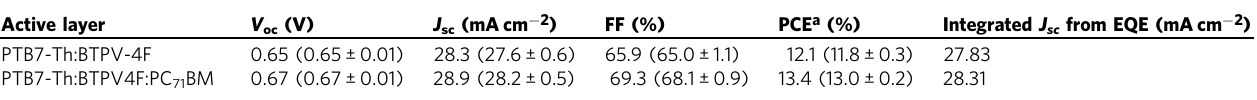
Table 1 Photovoltaic parameters of the optimal binary OSCs based on PTB7-Th:BTPV-4F (1:1.5, w/w) and ternary OSCs based on PTB7-Th:BTPV-4F (1:1.5:0.15, w/w/w) under the illumination of AM1.5 G, 100 mW cm − 2